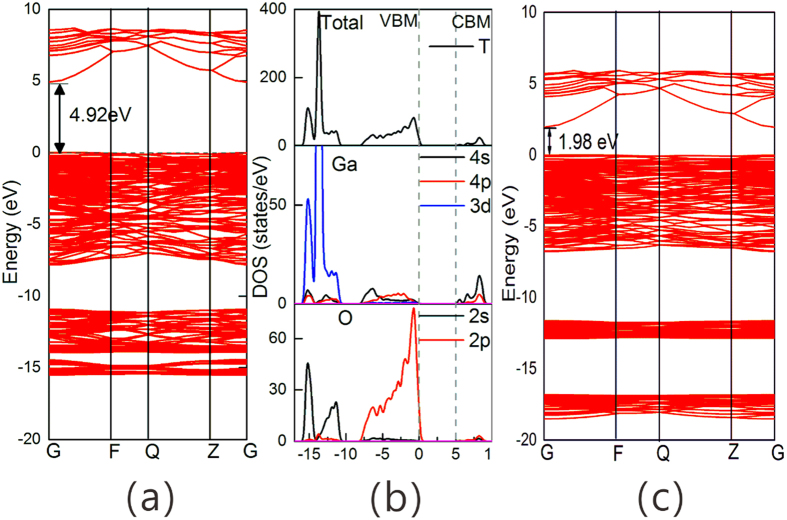
Band structure (a), DOS (b) under GGA+U, and band structure under GGA of intrinsic β-Ga2O3.